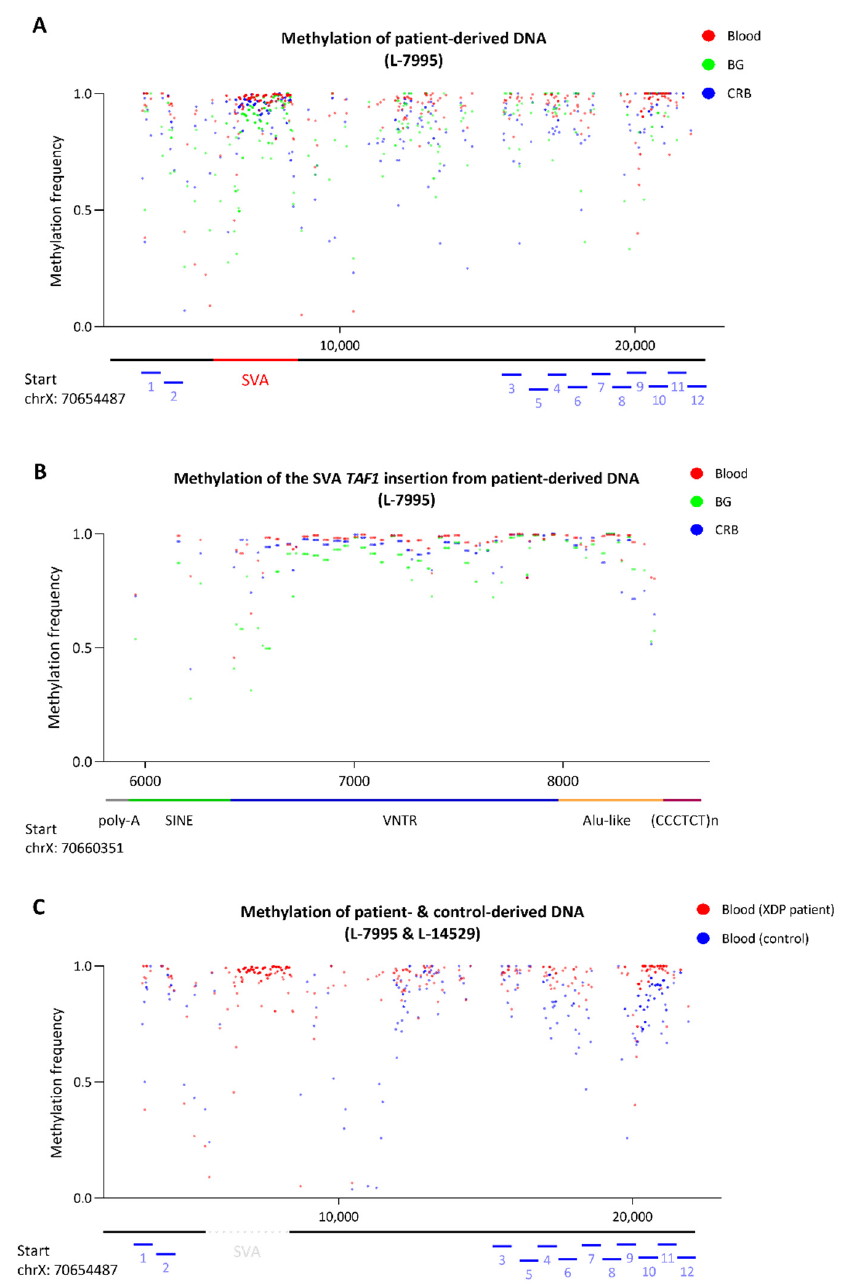
Figure 3. Methylation frequency of the TAF1 SVA insertion and flanking regions. ( A ) Methylation frequency of two different brain tissues and blood-derived from a patient with XDP. Red indicates methylation from blood-derived DNA, green from basal ganglia-derived (BG) DNA and blue from cerebellum-derived (CRB) DNA. ( B ) Methylation frequency of TAF1 SVA insertion with indicated SVA domains of the same patient-derived DNA samples. Red indicates methylation from blood-derived DNA, green from BG-derived DNA and blue from CRB-derived DNA. ( C ) Methylation frequency of blood-derived DNA from a patient with XDP (red) and a control participant (blue). The x -axis indicates the position in the reference sequence. The bars indicate the location of predicted enhancers, the TAF1 SVA insertion and the insertion’s subunits.